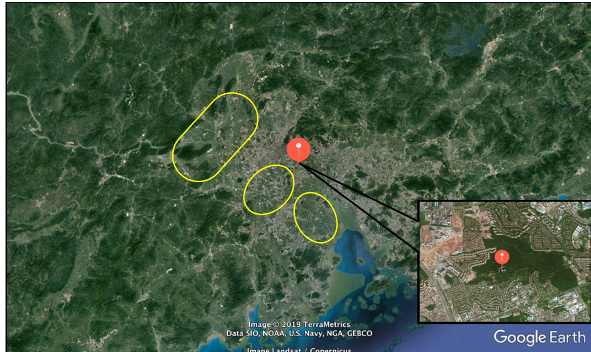
Figure 1. The location of Panyu station (CAWNET) in the PRD region (indicated by the red dot). The plain areas within the yellow circles are the main rural areas of the western PRD. © Google